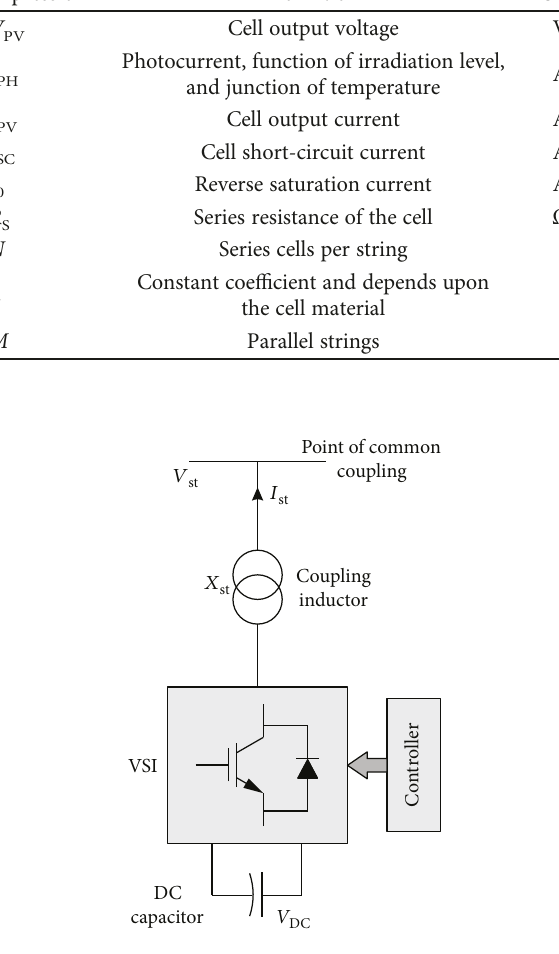
Figure 3: Basic structure of the STATCOM device.